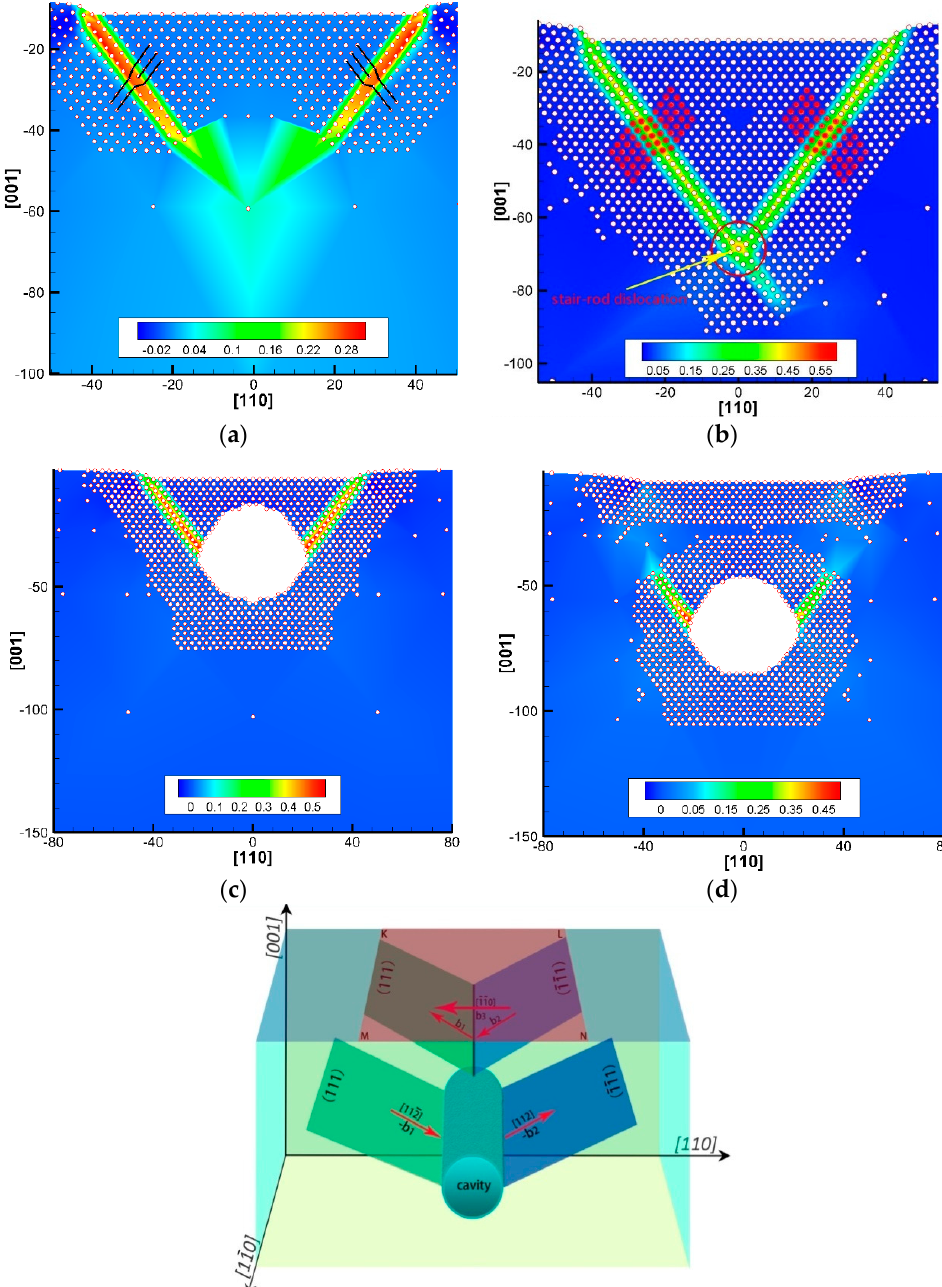
Figure 3. The dislocation structure at different yield point in Figure 2, ( a ) the ‘A’ point, ( b ) the ‘B’ point, ( c ) the ‘C’ point and ( d ) the ‘D’ point, and ( e ) schematic of two 1/6 <112> Shockley partial dislocations with Burgers vector of b 1 and b 2 on the (111) and (1(cid:3364)1(cid:3364)1) plane, respectively, and a stair-rod dislocation formed by the reaction of two partials, where the ‘KLMN’ region is the punching zone under the indenter.